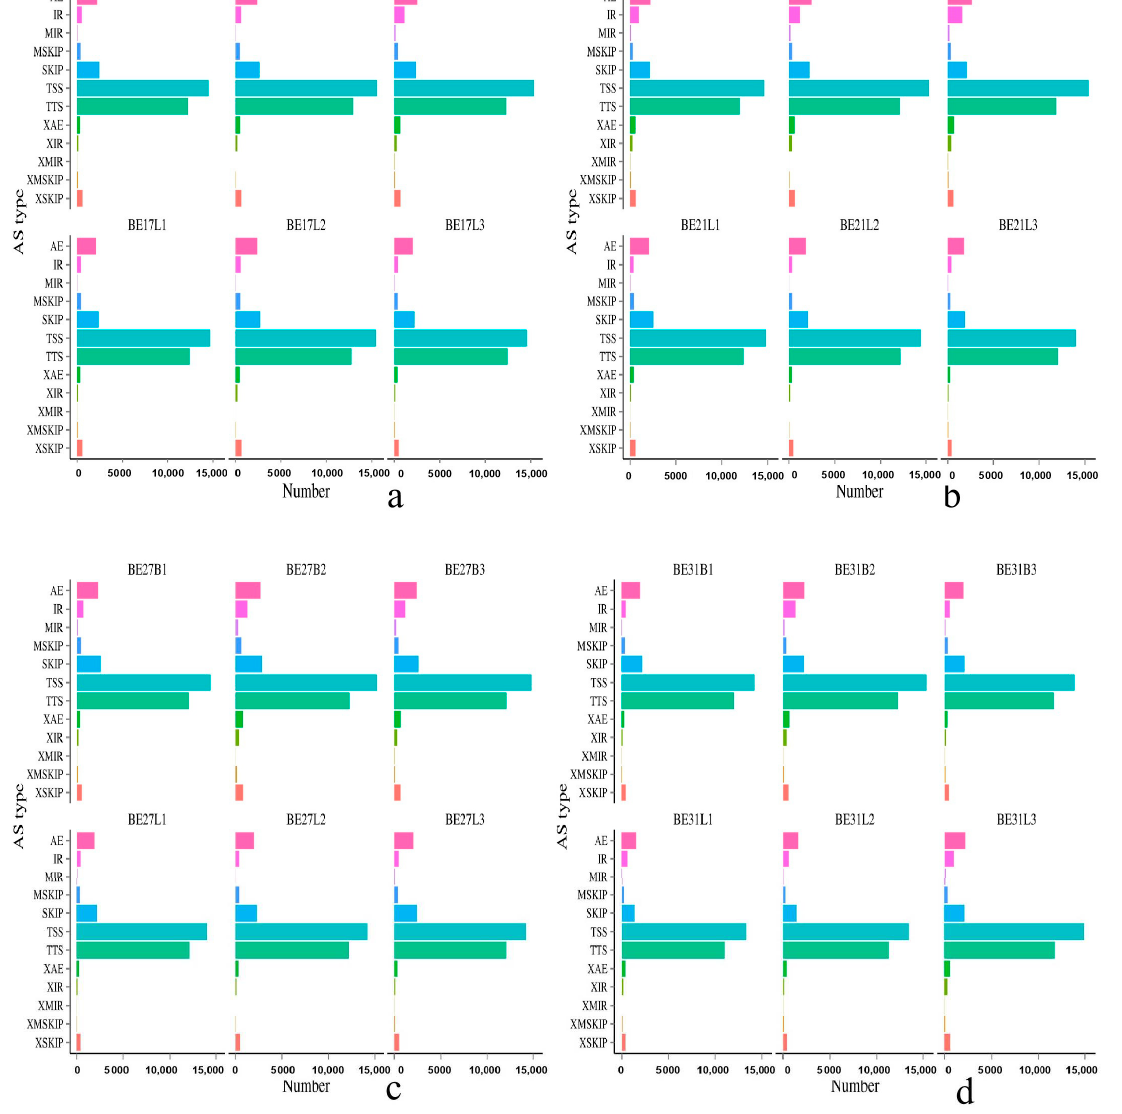
Figure 2. The predicted number of variable splices in black Muscovy ducks during di ff erent incubation stages. ( a – f ) represent the predicted number of variable splices in black Muscovy ducks on day 17, 21, 27, 31, and 34 of incubation and postnatal 6-month-old, respectively. Note: The horizontal axis represents number to one of alternative transcripts, the vertical axis represents types of alternative splicing